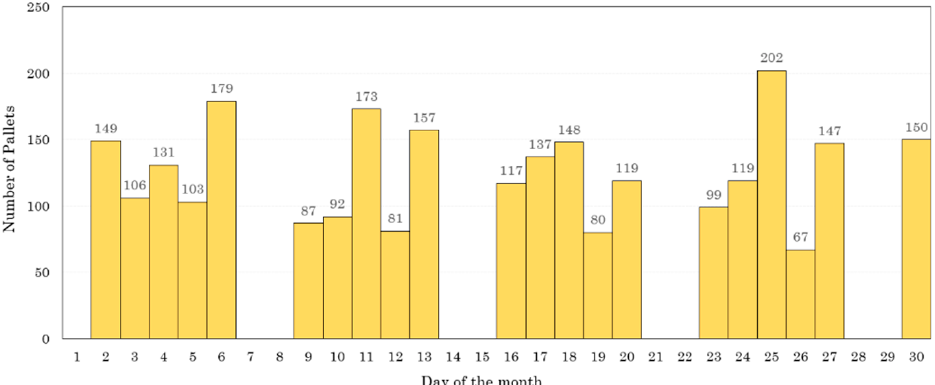
Figure 3. Number of Single Code pallets received per day in November 2020.